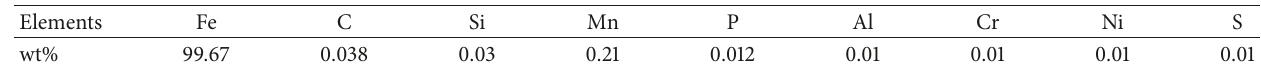
Table 2: Elemental composition of the